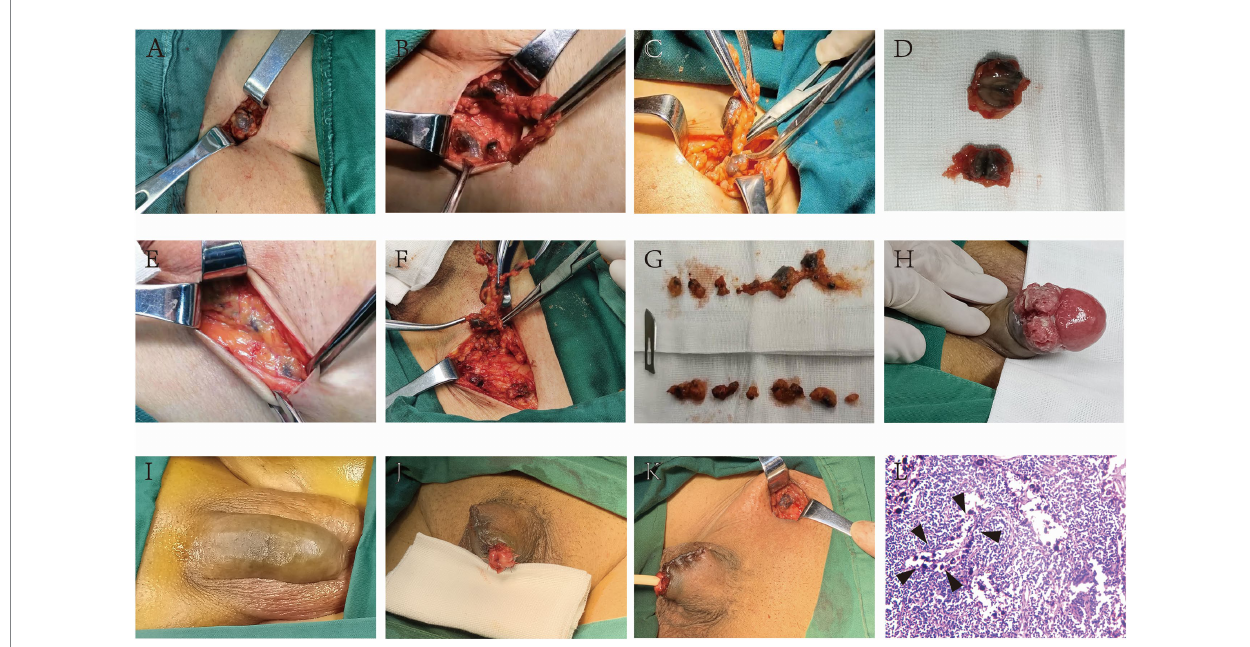
FIGURE 1 CNSI as a sentinel lymph node tracer for penile cancer has high accuracy and does not additionally influence the postoperative appearance and pathological analysis. The lymph node surface and cross-section showed a black staining appearance after the CNSI was applied (A–G) . The black- stained area caused by the injection of CNSI (H,I) is generally excised with the penis without additionally affecting the postoperative appearance (J,K) . HE staining of lymph node specimens showed that the CNSI was located at the edge of the lymphatic sinus and did not interfere with the reading of pathological sections (L)